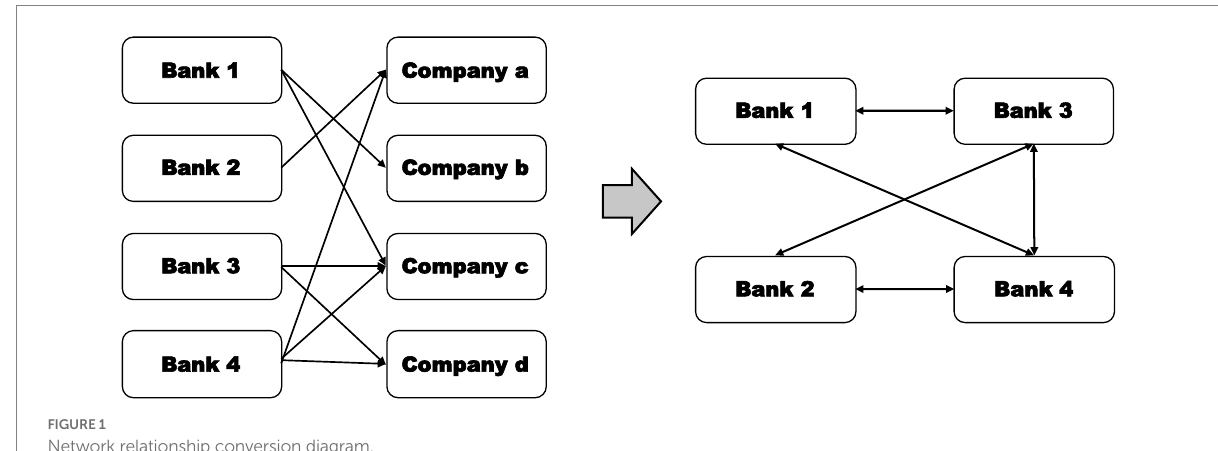
FIGURE 1 Network relationship conversion